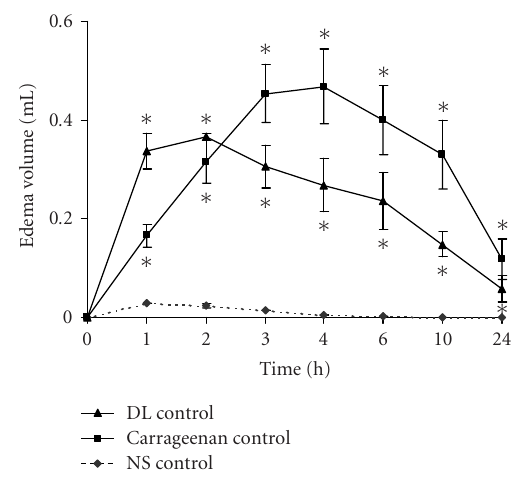
Figure 1. Time course for DL- and carrageenan-induced edema formation. Aqueous solution of DL of C procera (0.1mL of 1% solution), carrageenan (0.1mL of 1% solution), and NS (0.1mL) were injected into the subplantar surface of the rat paw and edema volume was measured at 1, 2, 3, 4, 6, 10, and 24 hours ( n = 6). ∗ P < . 05 versus NS